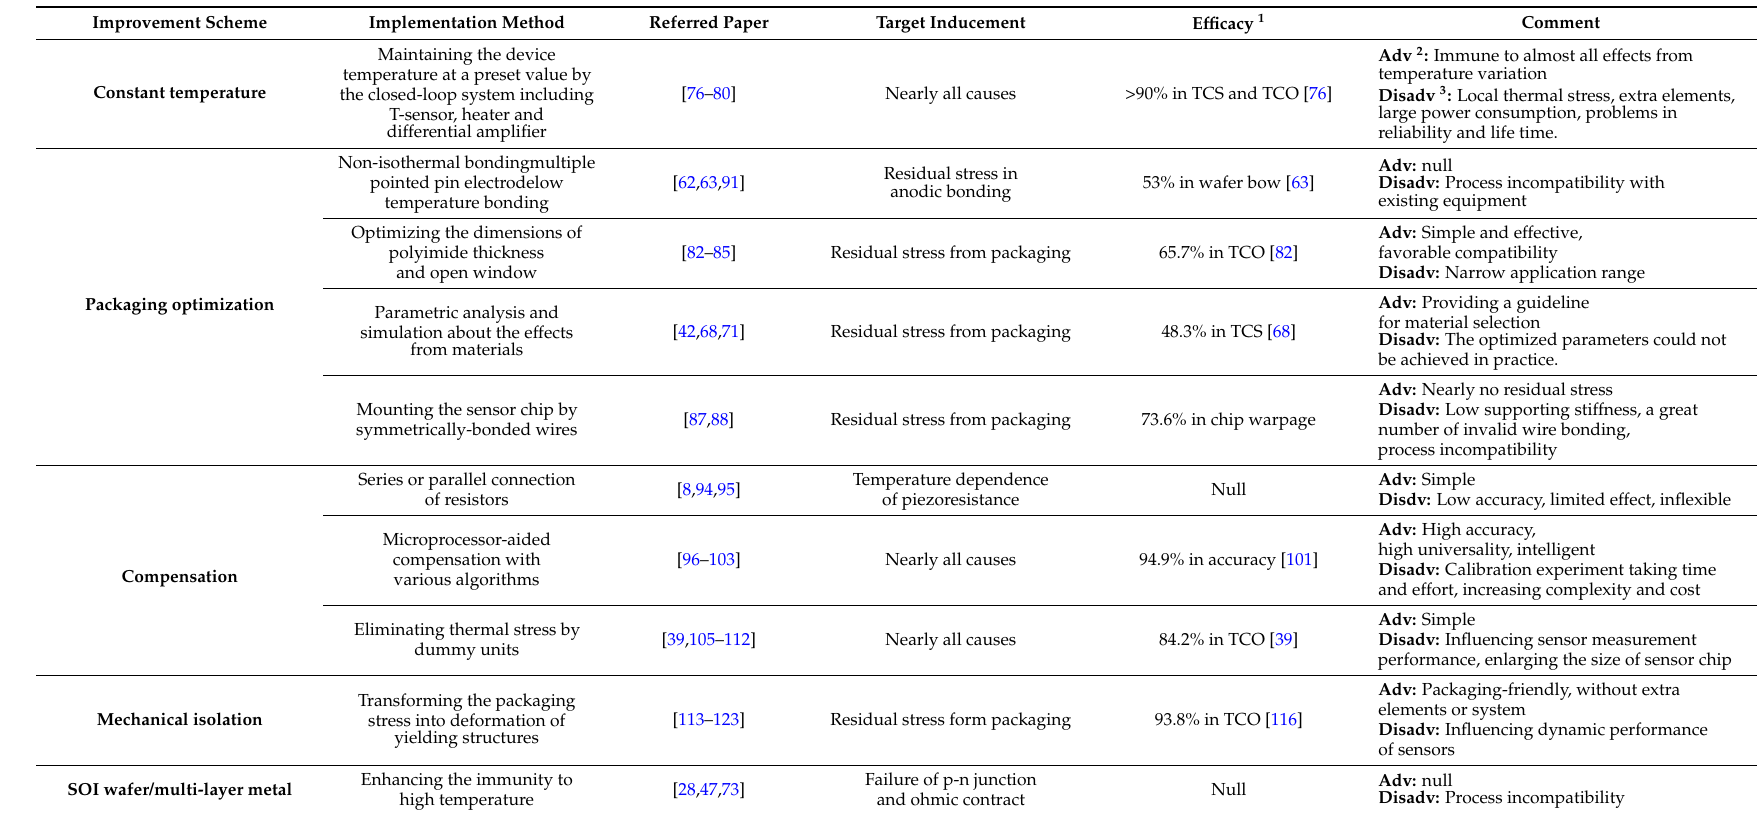
Table 1. Summary of available measures for improvement of thermal-performance instability in piezoresistive